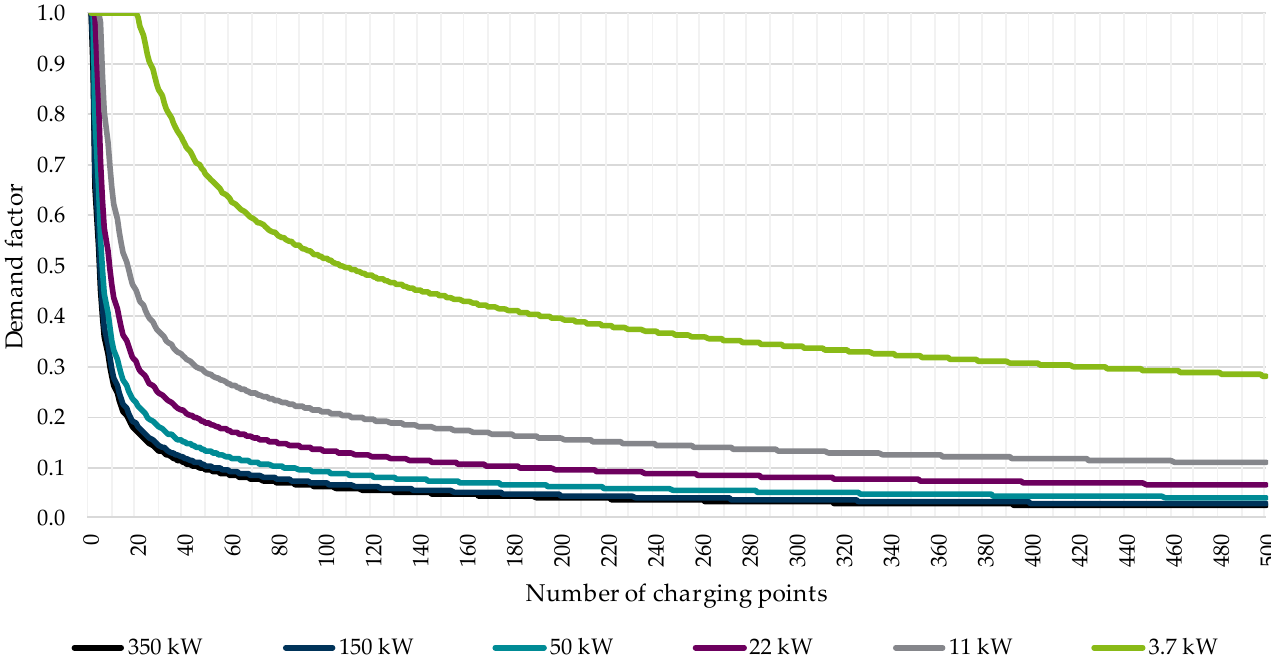
Figure 13. Demand factors (ordinate) for the area type “Urban Region: Medium-sized City, Urbanised Area” and six charging powers.